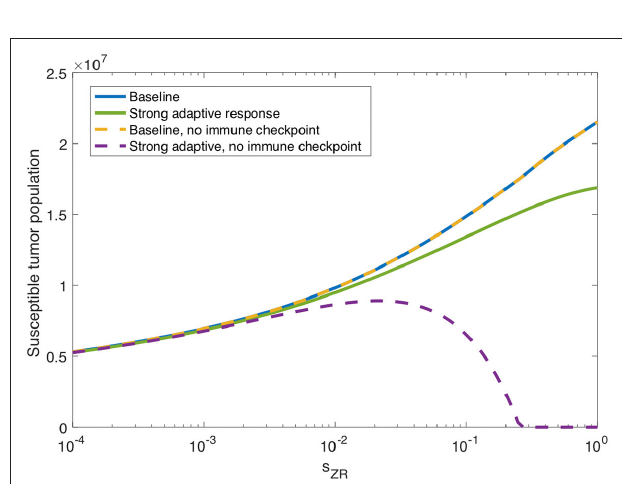
FIGURE 7 | Innate immunity tradeoff. We display the susceptible tumor population after 300 h without anti-PD-1, as the source of innate immune cells, s ZR varies. We compare the baseline parameter regime with a stronger adaptive immune response, given by a AT = 0.05, in the presence of suppression of T-cell activity via the PD-1/PD-L1 pathway and also in the absence of T cell suppression via the PD-1/PD-L1 pathway.